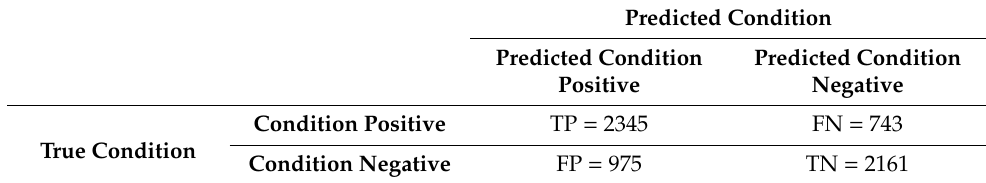
Table 6. Confusion matrix for kNN. (TP: true positive, TN: true negative, FN: false negative, FP: false positive).